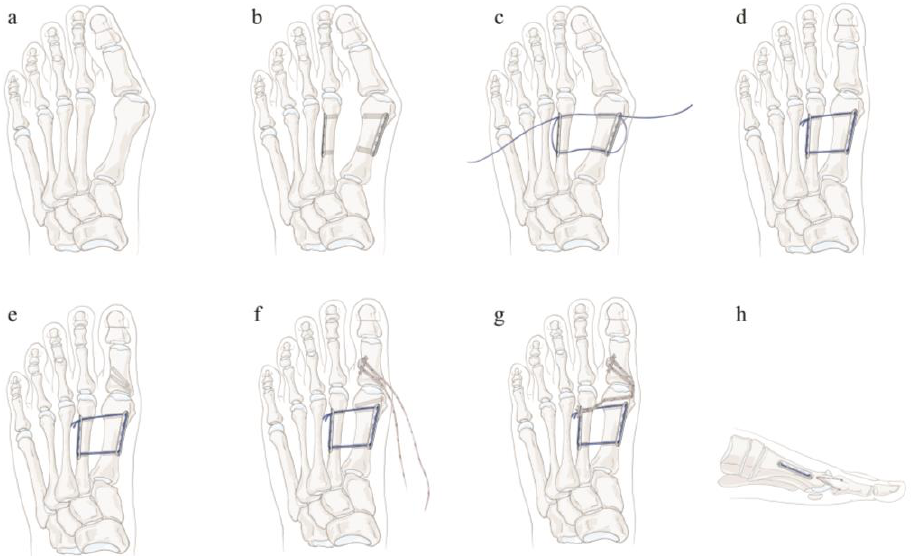
Figure 1. Illustration of the transosseous suturing technique. ( a ) Prepare two bone tunnels by drilling from the first metatarsal to the second metatarsal. ( b ) Subsequently, place two mini plates on the medial side of the first metatarsal bone and lateral side of the second metatarsal bone. ( c ) Pass Fiberwire through the two mini plates and bone tunnels at the metatarsal bones thrice. ( d ) After Fiberwire is set up properly, tighten it and anchor the suture on the plate. ( e ) If augmentation of the medial capsuloligamentous structure is required for a patient, drill two bone tunnels at the first proximal phalanx and one bone tunnel at the medial collateral ligament insertion site on the first metatarsal. ( f ) For medial capsuloligamentous augmentation, two Fiberwires were tied on the washer applied at the lateral side of the first proximal phalanx and passed through the dorsal- and plantar-side bone tunnels, respectively. ( g ) Then, two Fiberwires were passed through the first metatarsal at the medial collateral ligament insertion site and the second metatarsal distal bone tunnel. After passing through Fiberwires, the suture was anchored on the plate. ( h ) Lateral view of the final appearance of the structure.